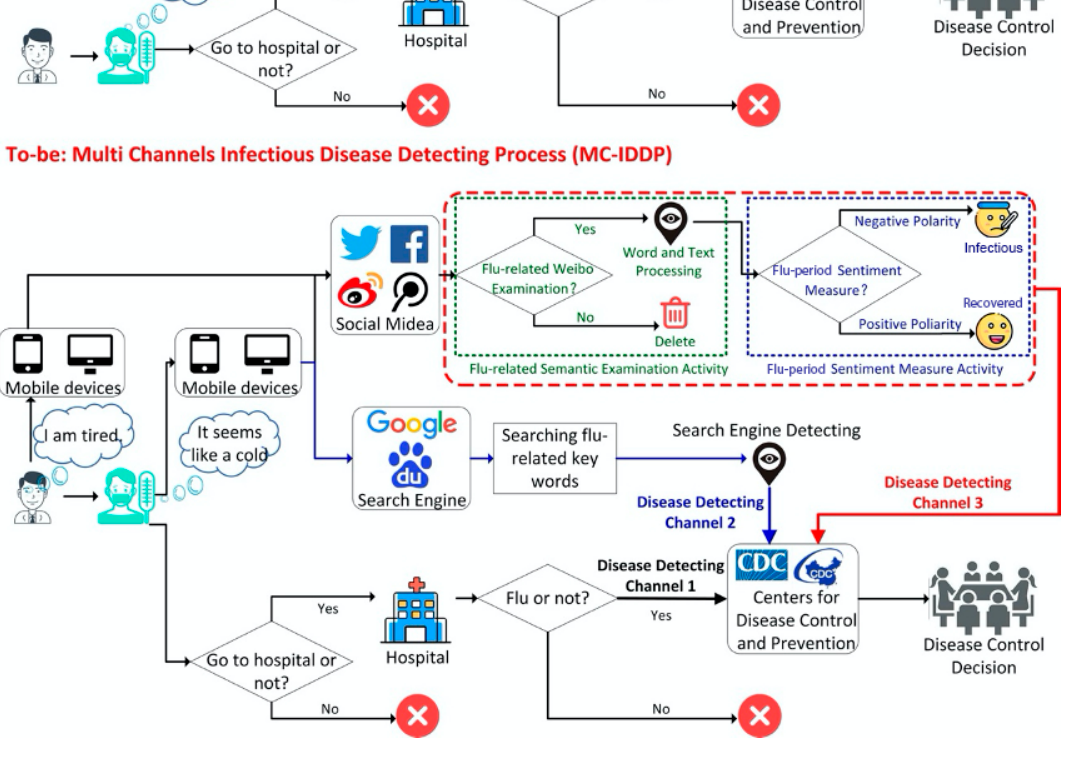
( b ) Figure 3. The Logical Structure Model of a Solitary Channel and Multiple Channels. ( a ) Solitary Channel; ( b ) Multiple Channels. The main parameters are described as follows. (cid:1840) represents the number of possible infectious people; (cid:1840) (cid:3004)(cid:2869)(cid:3020)(cid:3004) represents the number of possibly infectious people recorded by hospitals using a solitary channel; (cid:1840) (cid:3039)(cid:3042)(cid:3046)(cid:3047)(cid:3020)(cid:3004) represents the number of possibly infectious people but do not go to the hospital in a solitary channel; (cid:1840) (cid:3004)(cid:2869)(cid:3004)(cid:3005)(cid:3004) (cid:3020)(cid:3004) represents the number of infectious people who are diagnosed and reported to the CDC in a solitary channel; (cid:1840) (cid:3004)(cid:2869)(cid:3014)(cid:3004) represents the number of possibly infectious